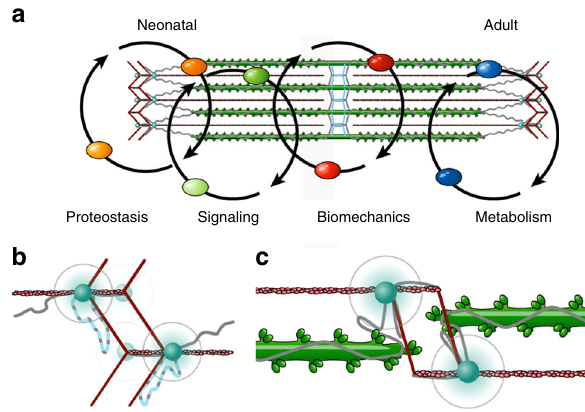
Fig. 6 Remapping sarcomere structure and function. a The sarcomere serves as a multi-protein hub that does not only determine the mechanical properties of striated muscle, but links to proteostasis and distinct signaling pathways in the neonatal heart and skeletal muscle vs. metabolic enzymes in adult tissue to meet local demand. b Revised model of actin/myosin/titin interactions at the Z-disc. The titin Z-disc loop (light blue) interacts with α - actinin (red rods). The biotin ligase (blue dot) is integrated between titin Ig7 and Ig8 folding back to the edge of the Z-disc. c As sarcomeres contract, myosin approaches and eventually penetrates the Z-disc at short physiological sarcomere